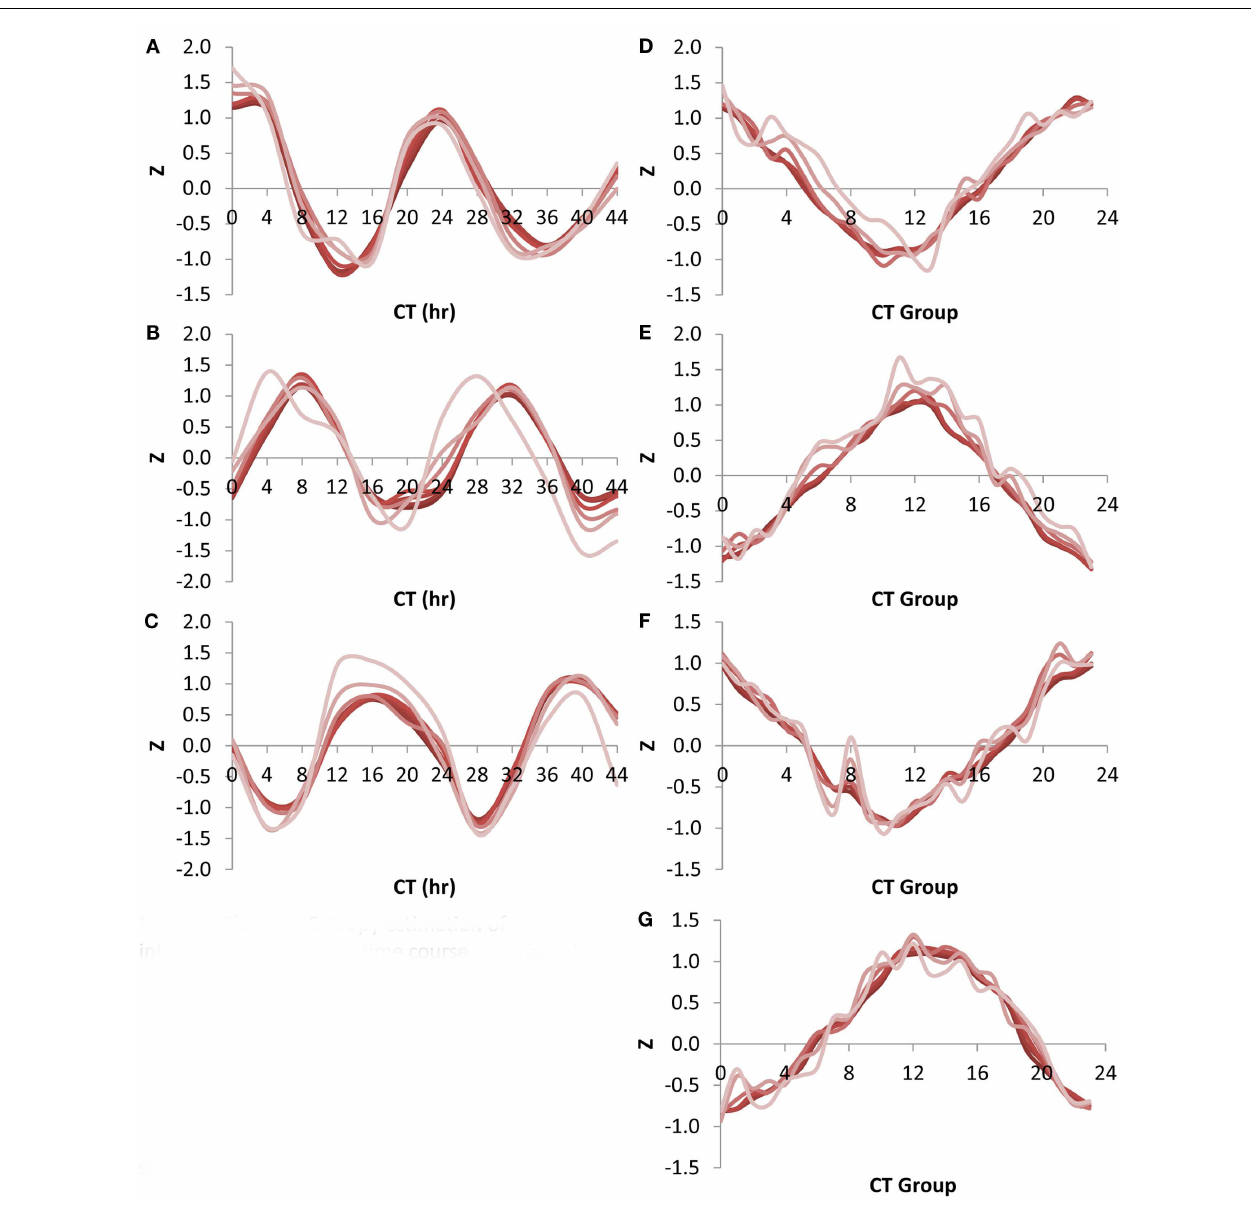
set sizes ranging from 22,746 in the darkest shade to 100 in the lightest shade. (A) Expression of CT Group 0 across time. (B) Expression of CT Group 8 across time. (C) Expression of CT Group 16 across time. (D) Expression of the 24 CT Groups at time CT 0. (E) Expression of the 24 CT Groups at time CT 12. (F) Expression of the 24 CT Groups at time CT 24. (G) Expression of the 24 CT Groups at time CT